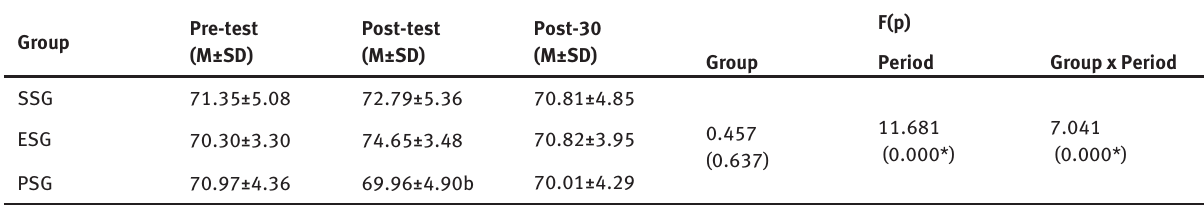
Table 2: The change of the blood flow velocity (unit: cm/s)